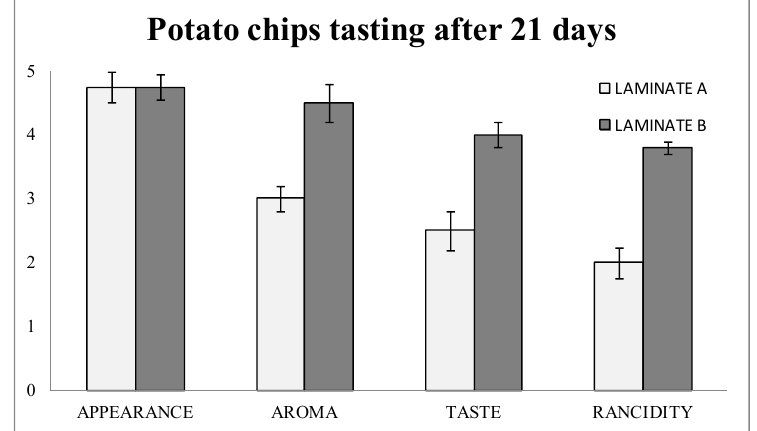
Figure 5. Sensory evaluations of potato chips packaged in laminate A (control) and laminate B (actives with nanoselenium particles) after 21 days.